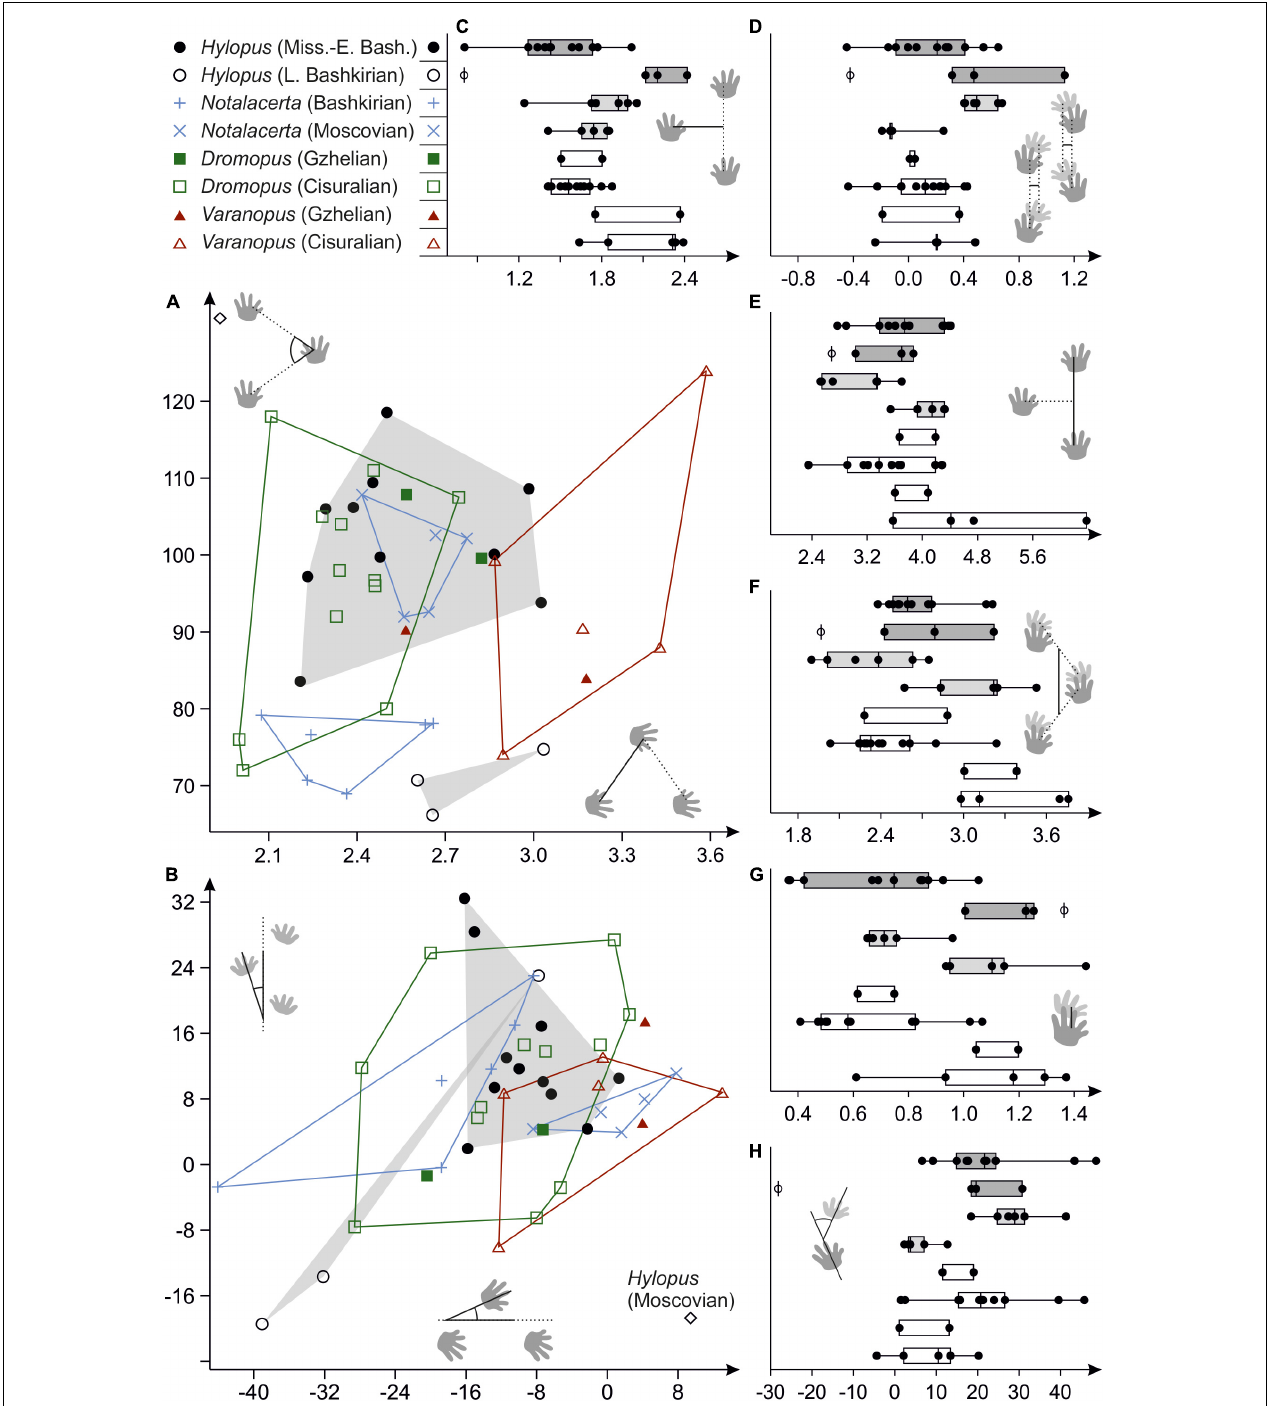
FIGURE 9 | Variability of trackway measures in Hylopus , Notalacerta , Dromopus and Varanopus from Mississippian to Pennsylvanian deposits and two Cisuralian reference samples ( Supplementary Material ), depicted as bivariate plots (A,B) and combined scatter plots/box-and-whisker plots (C–H) . (A) Pedal pace angulation (vertical axis) vs. pedal pace length (horizontal axis); (B) orientation for the manus imprints (vertical axis) vs. orientation of the pes imprints (horizontal axis) (with respect to the trackway midline; in degree); (C) normalized pedal gauge width; (D) normalized deviation between manual and pedal gauge width; (E) normalized pedal stride length; (F) normalized pedal gauge width; (G) normalized pes-manus along-track distance; (H) normalized deviation between manus and pes imprint orientation (in degree). The sole trackway of Hylopus from the Moscovian of Germany is represented by the empty circle (phi symbol) in (C–H) .